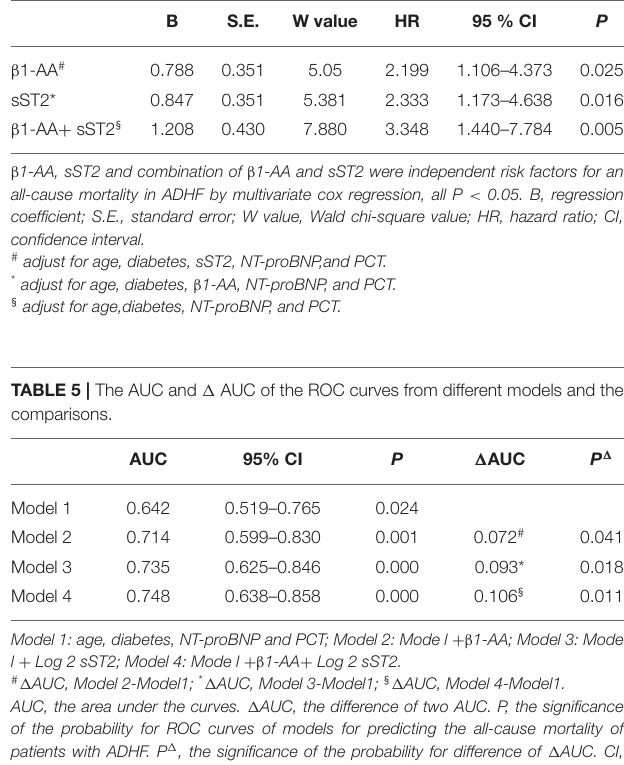
TABLE 4 | Association between level of β 1-AA/sST2 and all-cause mortality by Multivariate Cox regression. B S.E. W value HR 95 % CI P